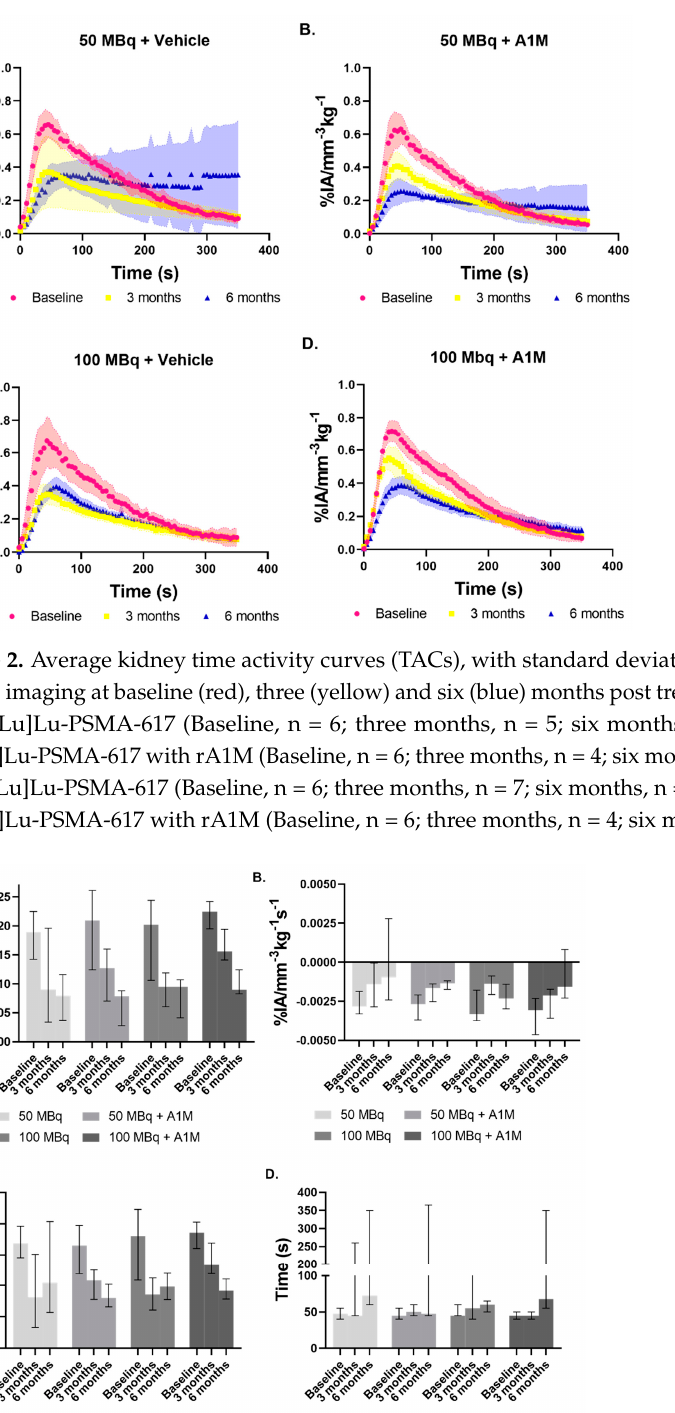
Figure 3. [ 99m Tc]Tc-MAG3 kidney TACs median and range. ( A ) The slope of initial uptake (SIU) i.e., the inclination the first 5–35 s. ( B ) Excretion in all groups over time. ( C ) TAC peak uptake values. ( D ) Time to peak. Examining individual changes in relation to their baseline measurements was done by plotting the baseline values (% IA mm − 3 kg − 1 ) obtained from [ 99m Tc]Tc-MAG3 prior to injection of [ 177 Lu]Lu-PSMA-617 against the corresponding, in seconds post injection of [ 99m Tc]Tc-MAG3, values obtained three months post injection, with the baseline peak as cut-off for accumulation and excretion. In both individual data and in the total cohort